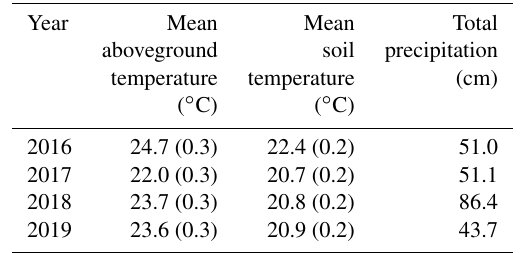
Table 2. Growing season (May–September) temperature and pre- cipitation. Temperature data are means (SE) of daily averages from ambient plots, and precipitation is the total from May through